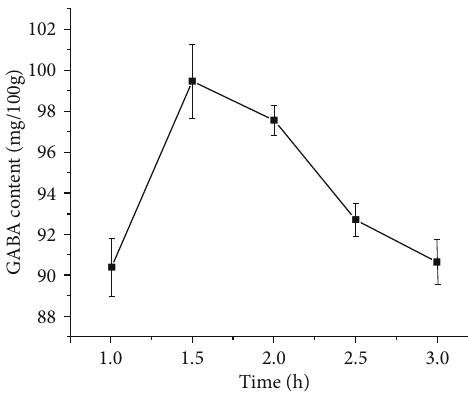
Figure 14: E ff ect of time on the GABA